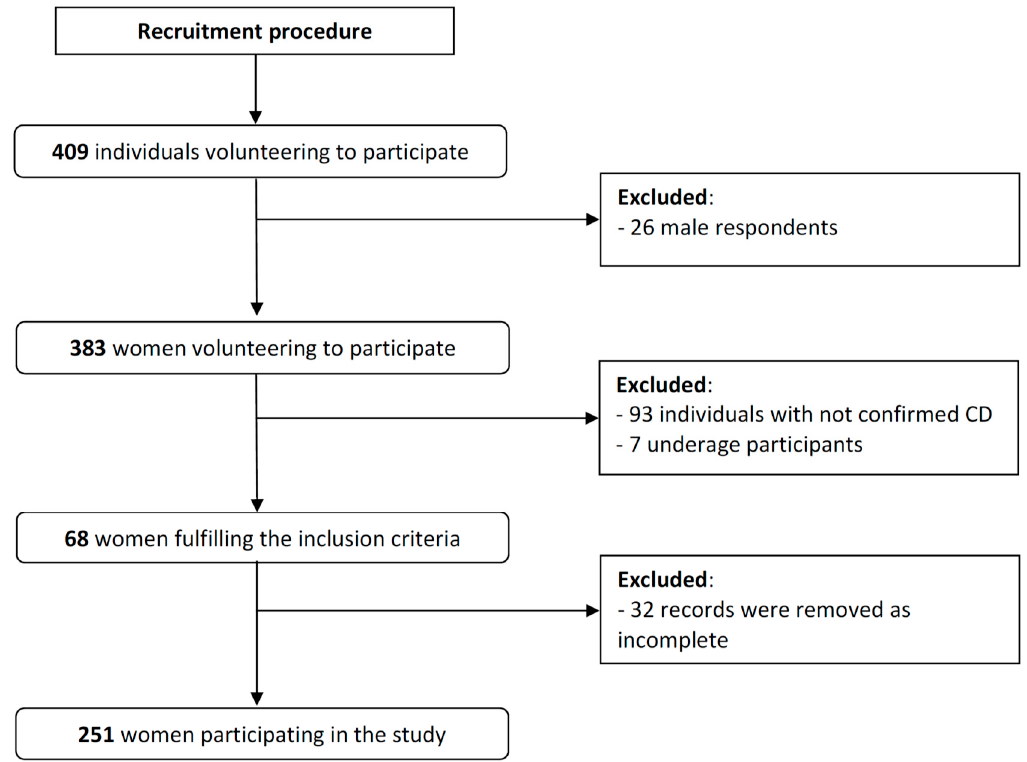
Figure 1. Participants inclusion to the study.